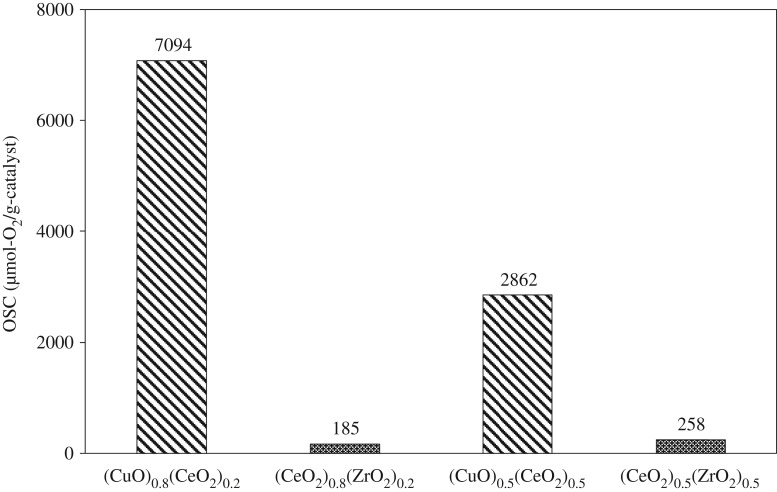
Comparison of total OSC at 300°C of CuO–CeO2 and CeO2–ZrO2-milled powder.